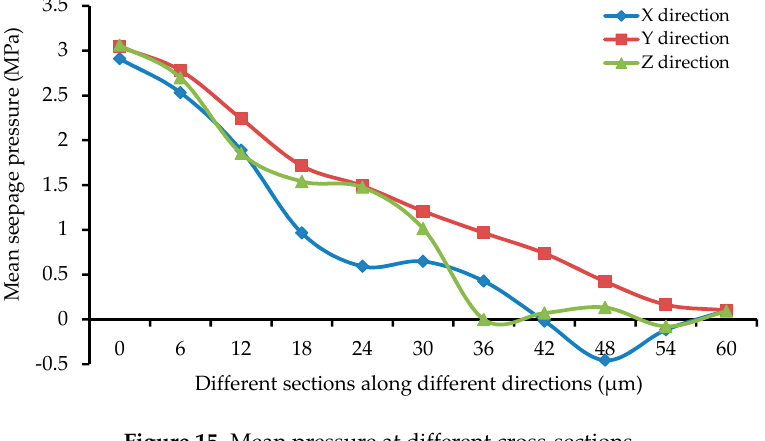
Figure 15. Mean pressure at different cross-sections .